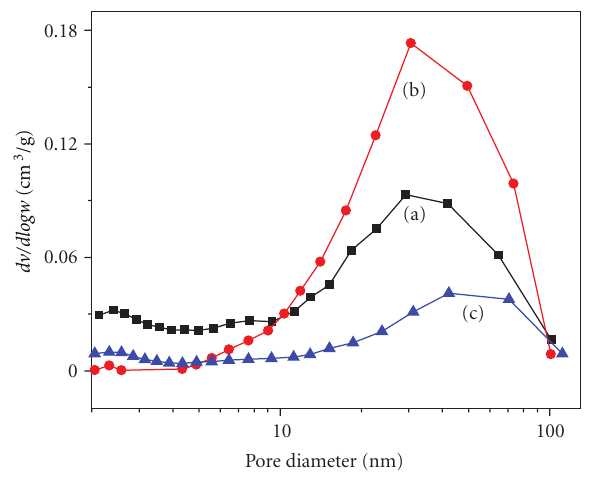
Figure 6: Pore diameter distribution curves of the P25 powders before (a) and after calcination at 500 (b) and 700 ◦ C (c) for 4 h.